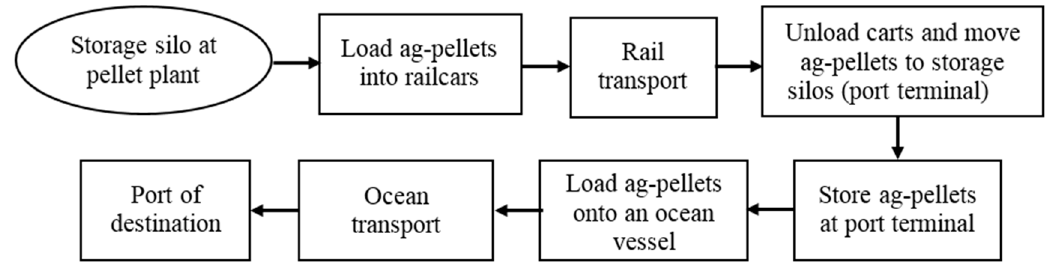
Figure 4. Distribution and delivery of ag-pellets from the pellet plant to the port of destination.